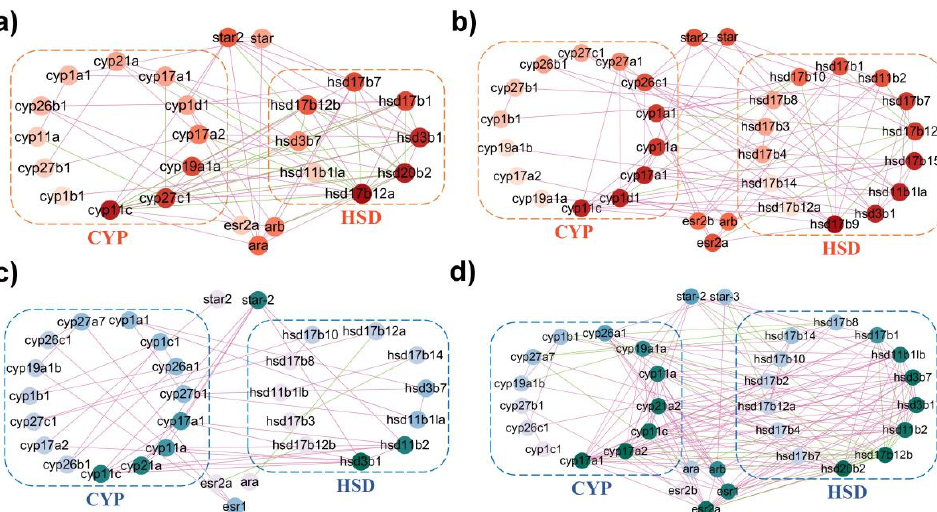
Figure 6. Network analysis of steroidogenic enzymes in P. olivaceus and C. semilaevis with Pearson’s correlation coefficient (PCC) of FPKM values. ( a , b ) represent networks in P. olivaceus corresponding to Figure 5a,b; ( c , d ) represent networks in C. semilaevis corresponding to Figure 5c,d. Red lines indicate positive correlation of PCC > 0.8 and green lines indicate negative correlation of PCC < − 0.8.